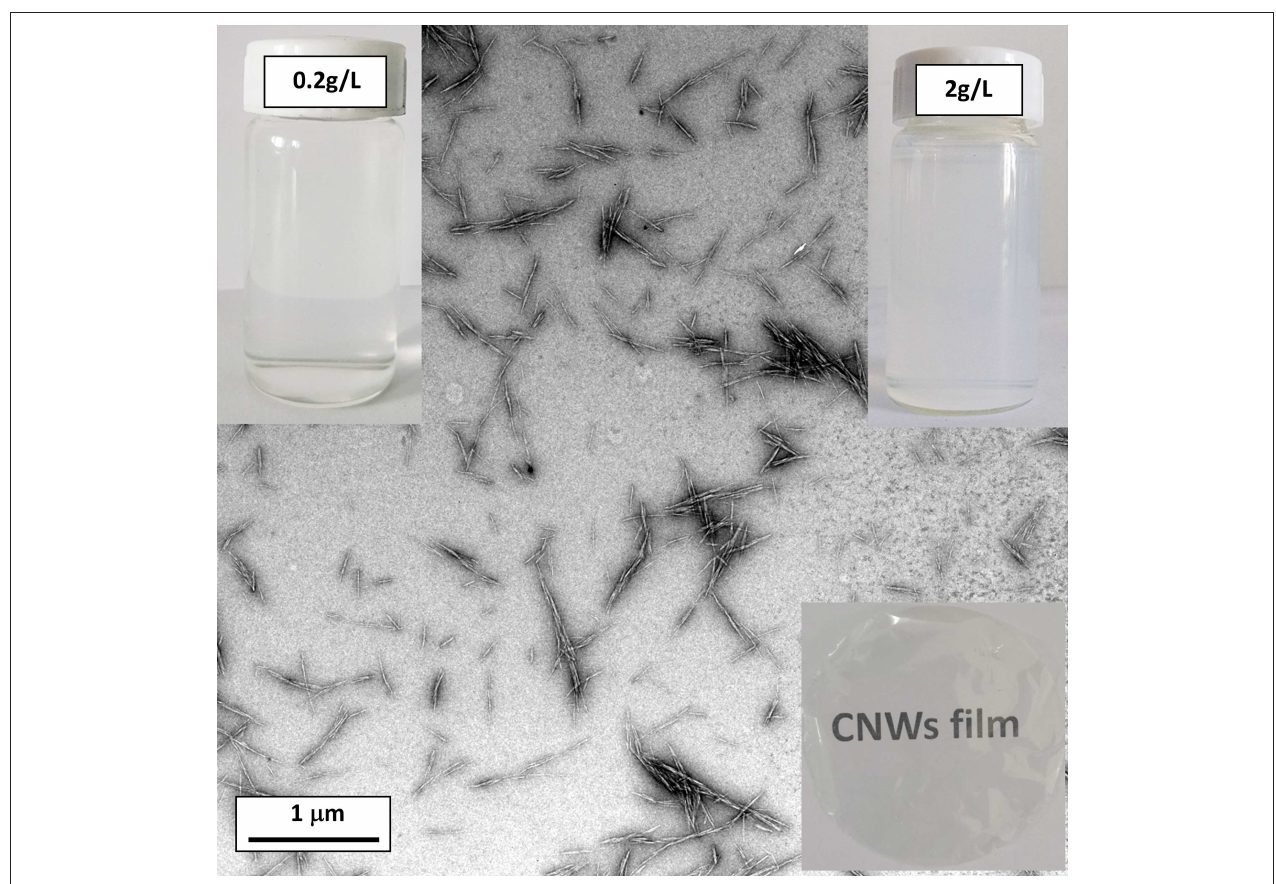
FIGURE 1 | TEM images of dispersed CNWs at the concentration of 0.2 g/L (inset: aqueous CNW suspensions at the CNW concentrations of 0.2 and 2 g/L on the top left and right, respectively, and transparent film on the bottom right).